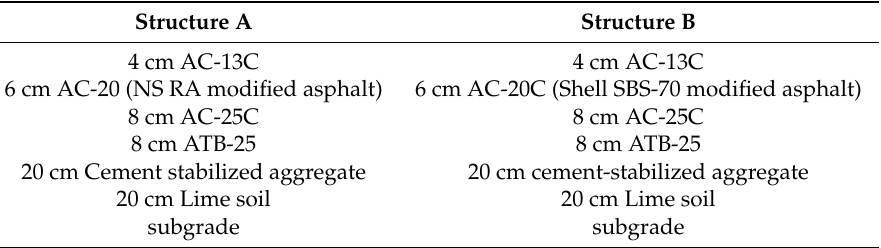
Table 5. Pavement structure of